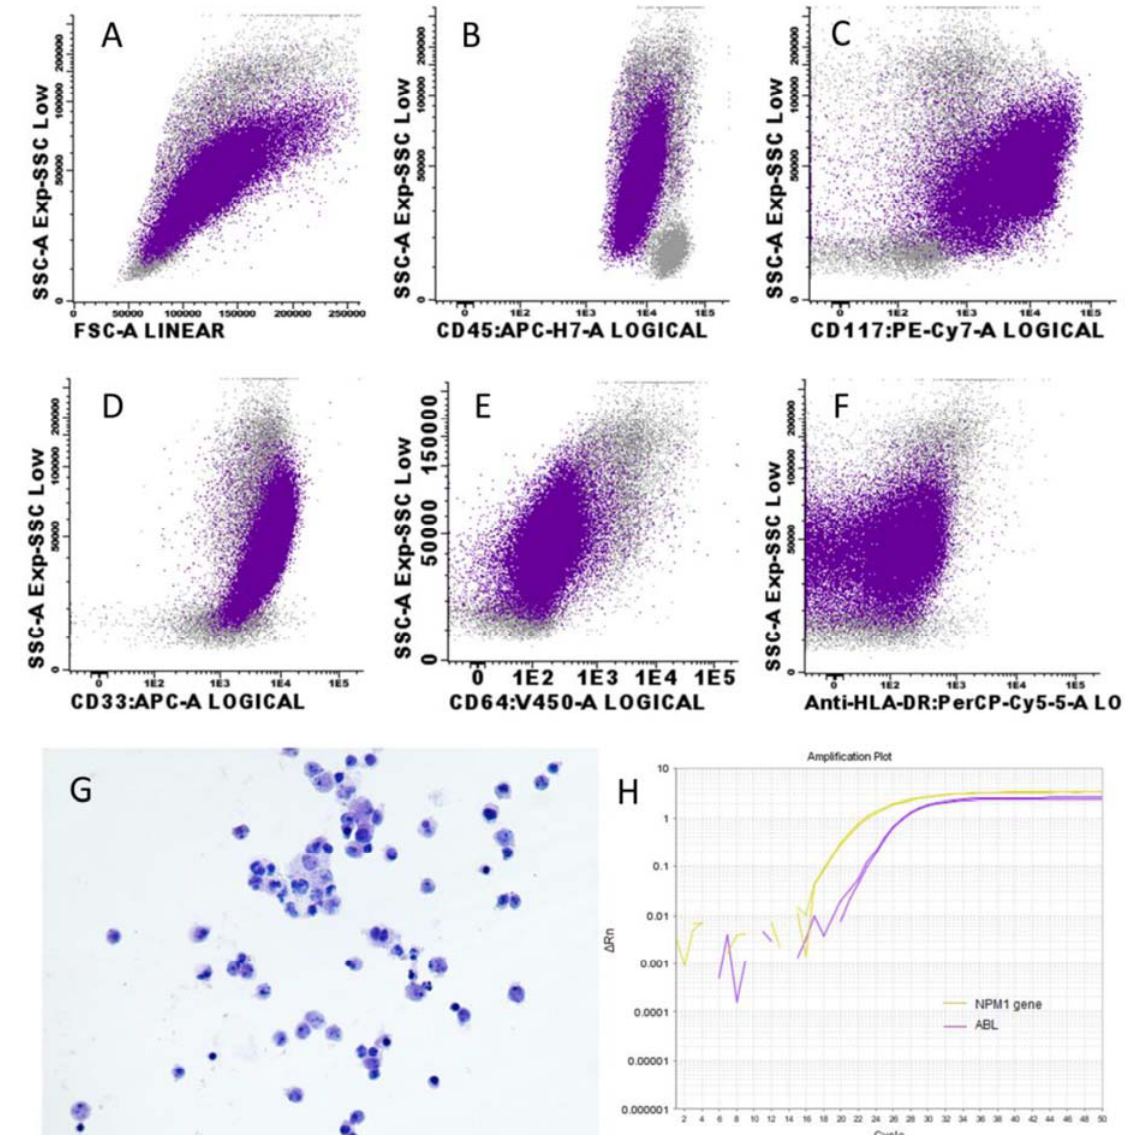
Figure 1. Study of ascitic fluid employing different techniques: ( A – F ) Blasts had high size and complexity and moderate CD45 expression. The blasts were positive for CD33 (bright), CD117, CD64 (dim) and CD13 (dim, not shown). The blasts were negative for HLA-DR and CD15 (not shown); ( G ) Ascitic fluid infiltration by mixed inflammatory cellularity, predominantly lymphocytic polymorphic appearance and scarce mesothelial epithelial cellularity; ( H ) NPM1 mutation A-allele-specific PCR showing NPM1 and ABL curves of amplification in duplicates.